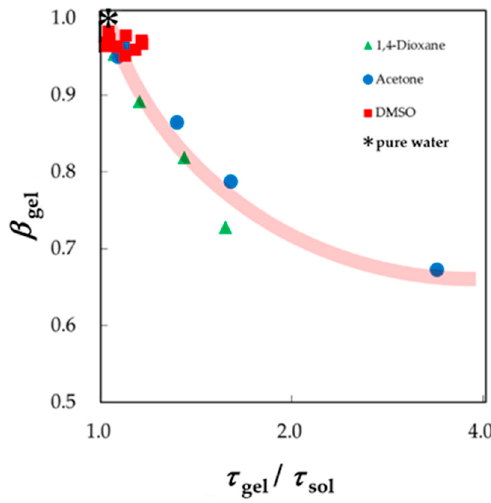
Figure 12. A new τ – β diagram for solvent mixtures in gels. The relaxation time is normalized, similar to that obtained for bulk solvents.